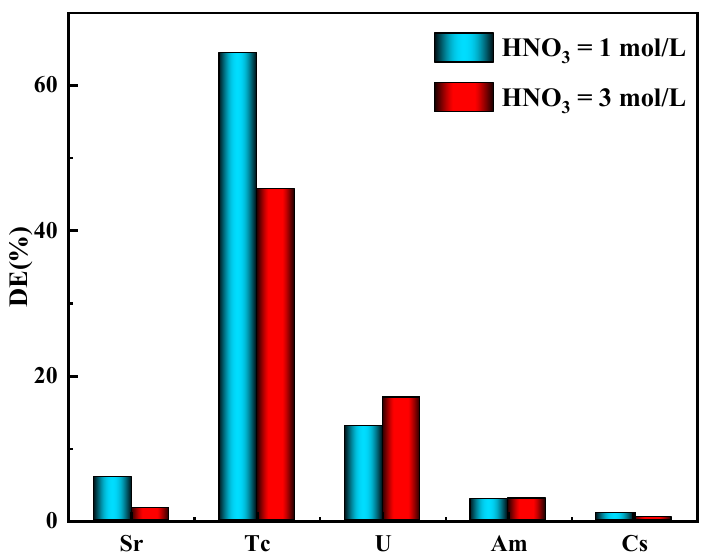
Figure 10. The decontamination efficiency of 90 Sr, 99 Tc, 137 Cs, 241 Am, and U for N3/SiO 2 in radioactive liquid waste, with the following adsorption conditions: V / m = 10 cm 3 /g, T = 25 °C, and 12 h.